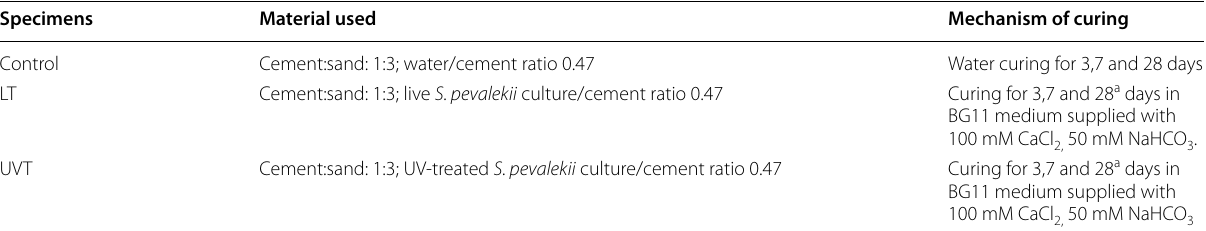
a Mortar cubes were incubated in culture for 24 h. at the beginning of every week and then transferred to medium